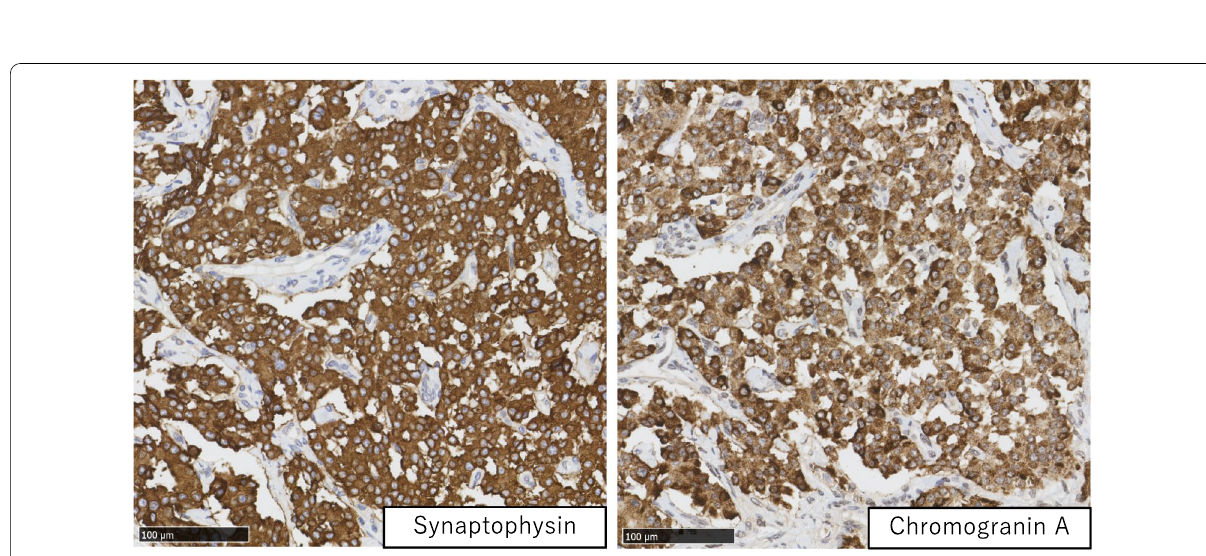
Fig. 6 Findings of immunohistochemistry. Immunostaining shows positivity for chromogranin A and